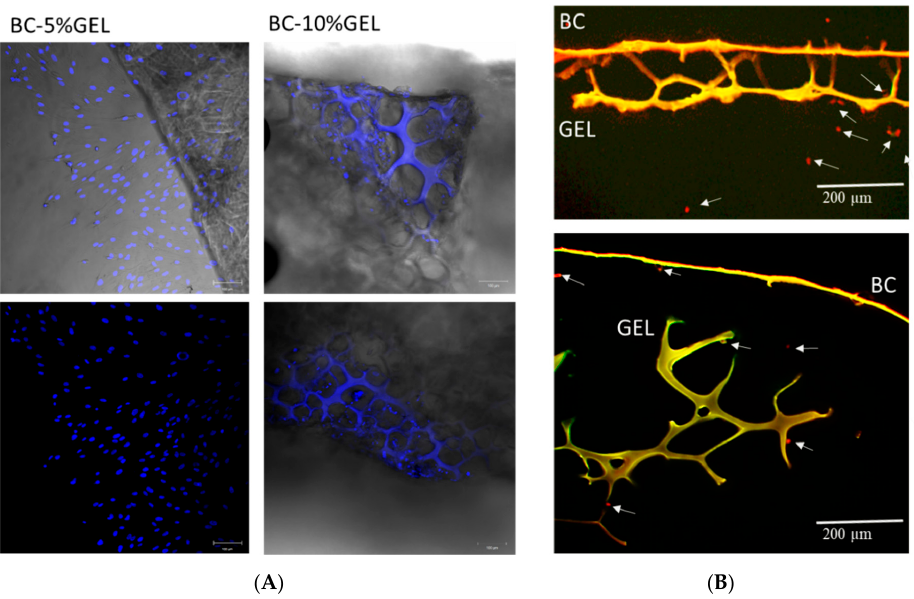
Figure 8. ( A ) CFM images of BC–5%GEL and BC–10%GEL membranes on whole mounts. Cell nuclei as well as autofluorescence of the samples are seen (blue); ( B ) CFM images of membrane cross-sections with assigned BC and GEL segments and pointed-arrow cells. Cells were labeled red during image processing for better contrast and visualization.